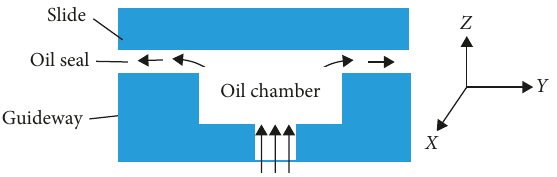
Figure 1: Structure of a hydrostatic